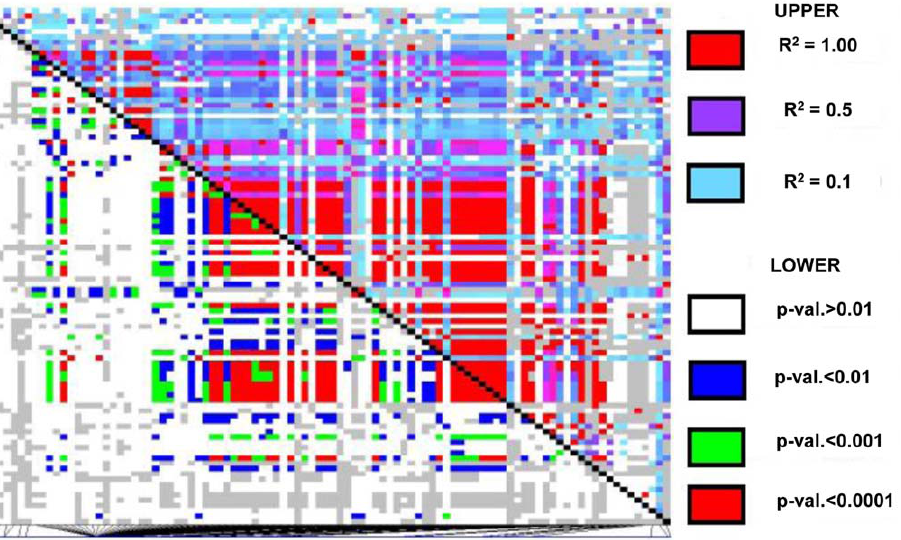
Figure 8. LD plot containing ZmLOX12 and the 100 kb flanking the gene both upstream and downstream. The LD plot of SNPs from the Maize HapMap ZmLOX12 , and the flaking 100 kb on either side of the gene shows that LD at this locus is very strong and extends farther than expected in maize. Approximately 3,000 bp across the ZmLOX12 gene and extends beyond to approximately 19,000 bp. Further investigation of this locus revealed that there is a predicted gene of unknown function located very near ( , 100 bp) to ZmLOX12 .